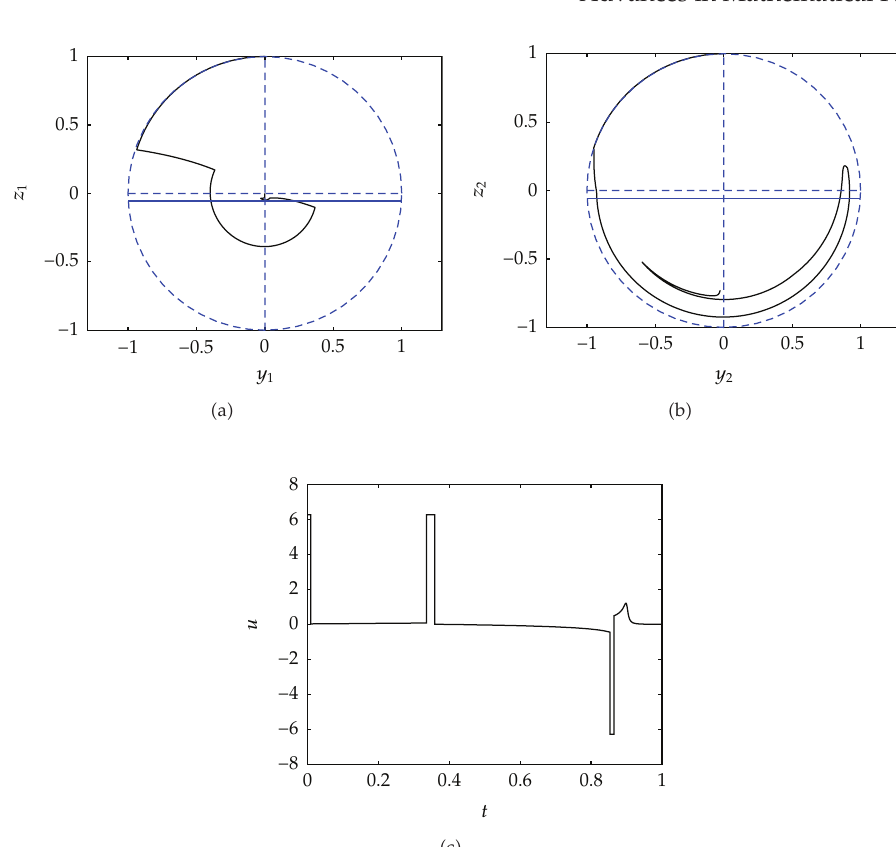
Figure 10: It is the same as Figure 9 but for a control field of the form BSBSBS with t f (cid:5) 1 . 1 T min .